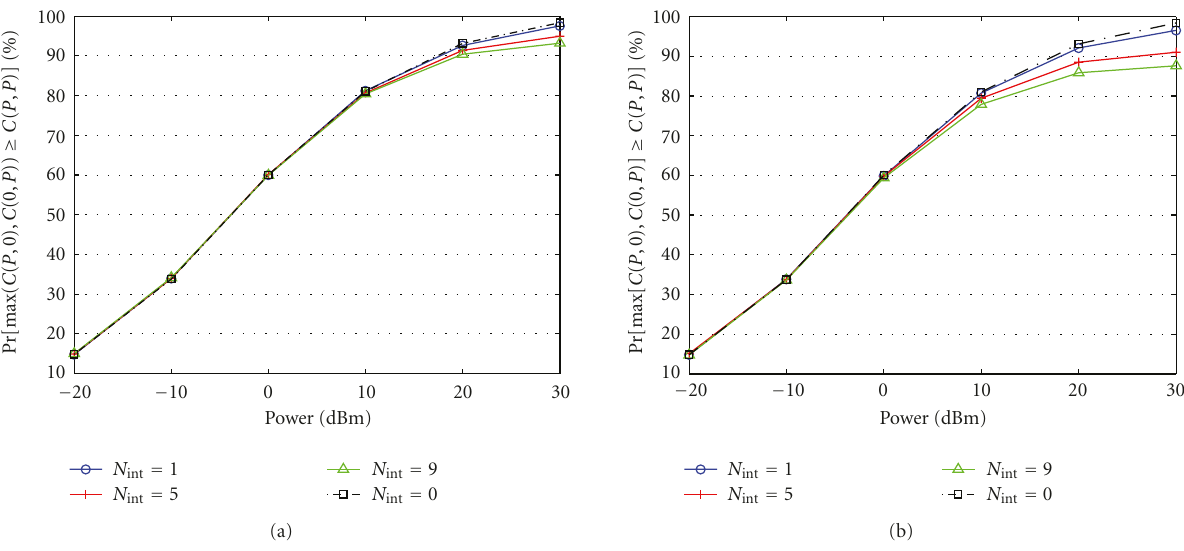
Figure 10: Percentage of points where single outperforms simultaneous transmission at di ff erent power levels and number of background interferers N int . The e ff ect of background interference is only noticeable for high power levels P , and further diminishes by increasing the exclusion region R ex . (a) Exclusion radius R ex = 500 m, (b) Exclusion radius R ex = 50 m.